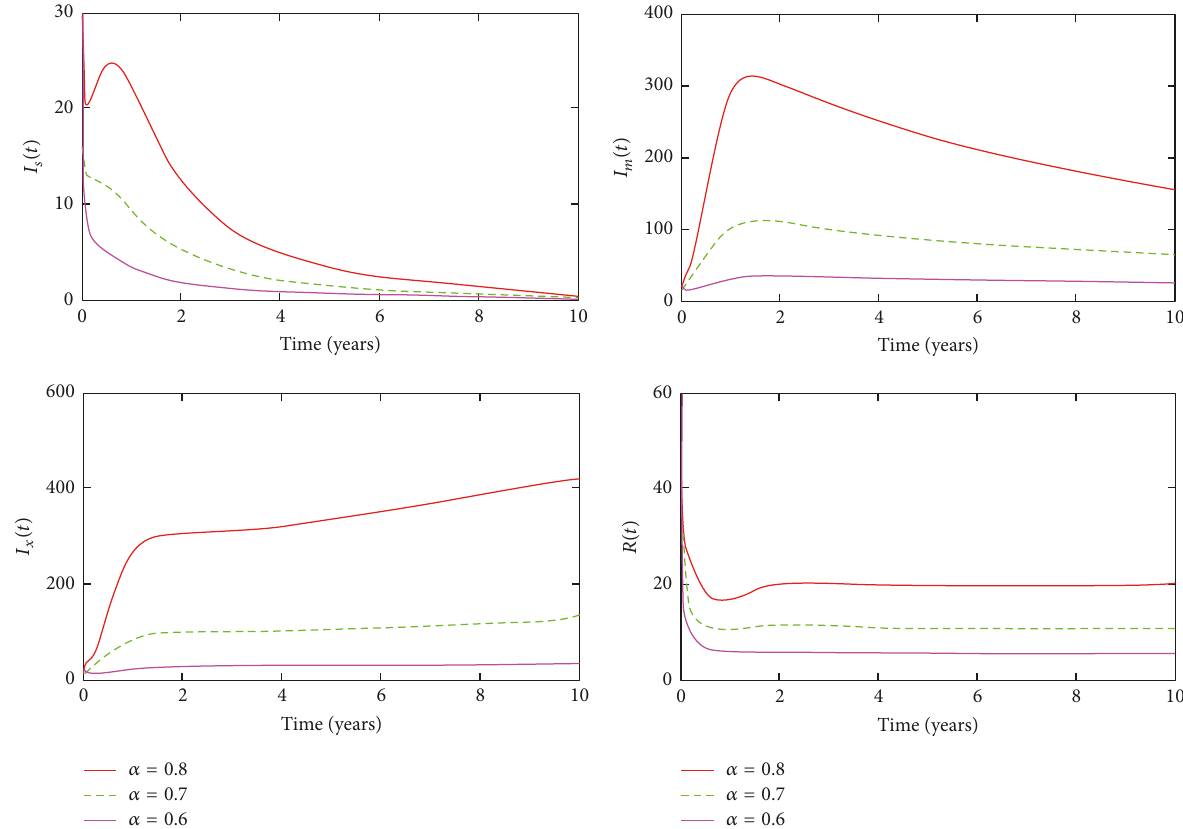
Figure 12: The approximate solutions with 𝜏 = 0.4 and different 𝛼 using